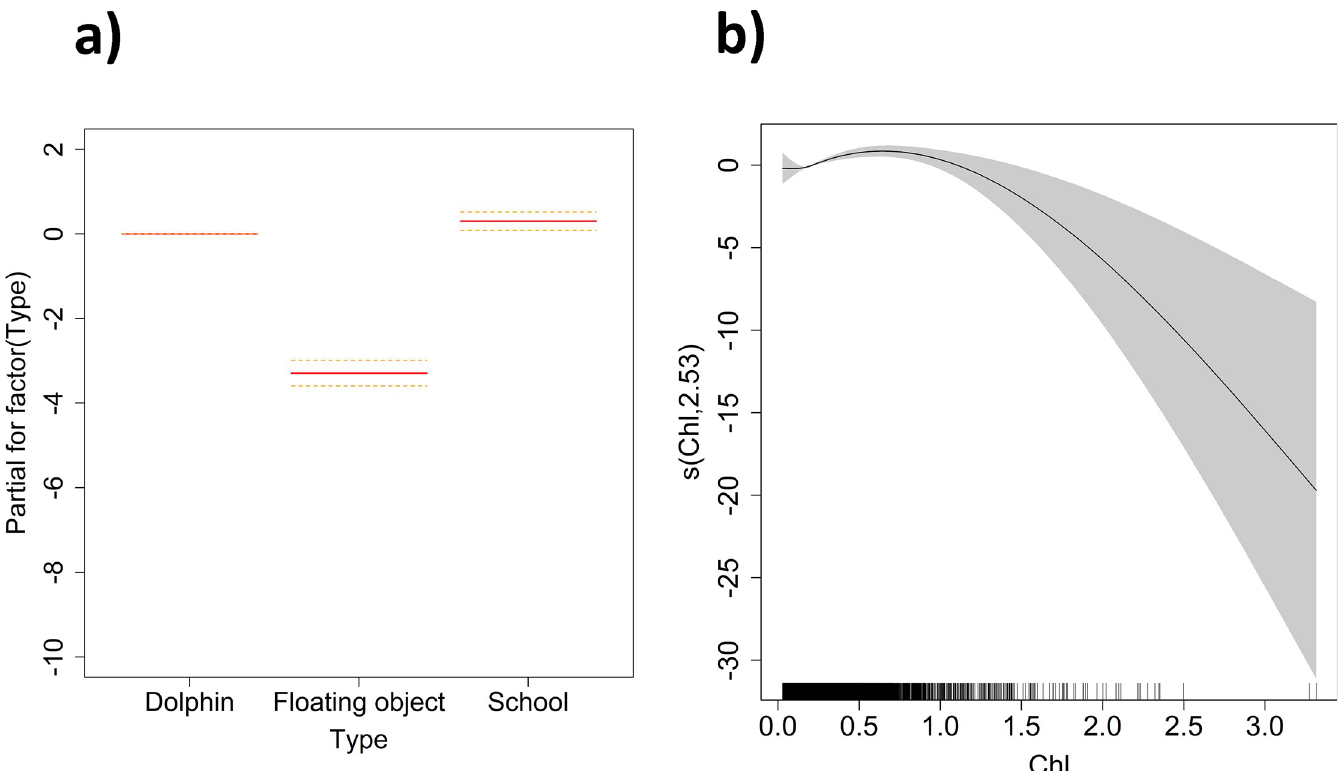
Fig 3. Smoothed fits of covariates modeling the presence of Mobula mobular for: a) Type of set (Dolphin vs. Floating object vs. School) and Chl (chlorophyll, in mg � m -3 in x-axis) variables. The y-axis represents the spline function. Shaded polygons indicate approximate 95% confidence